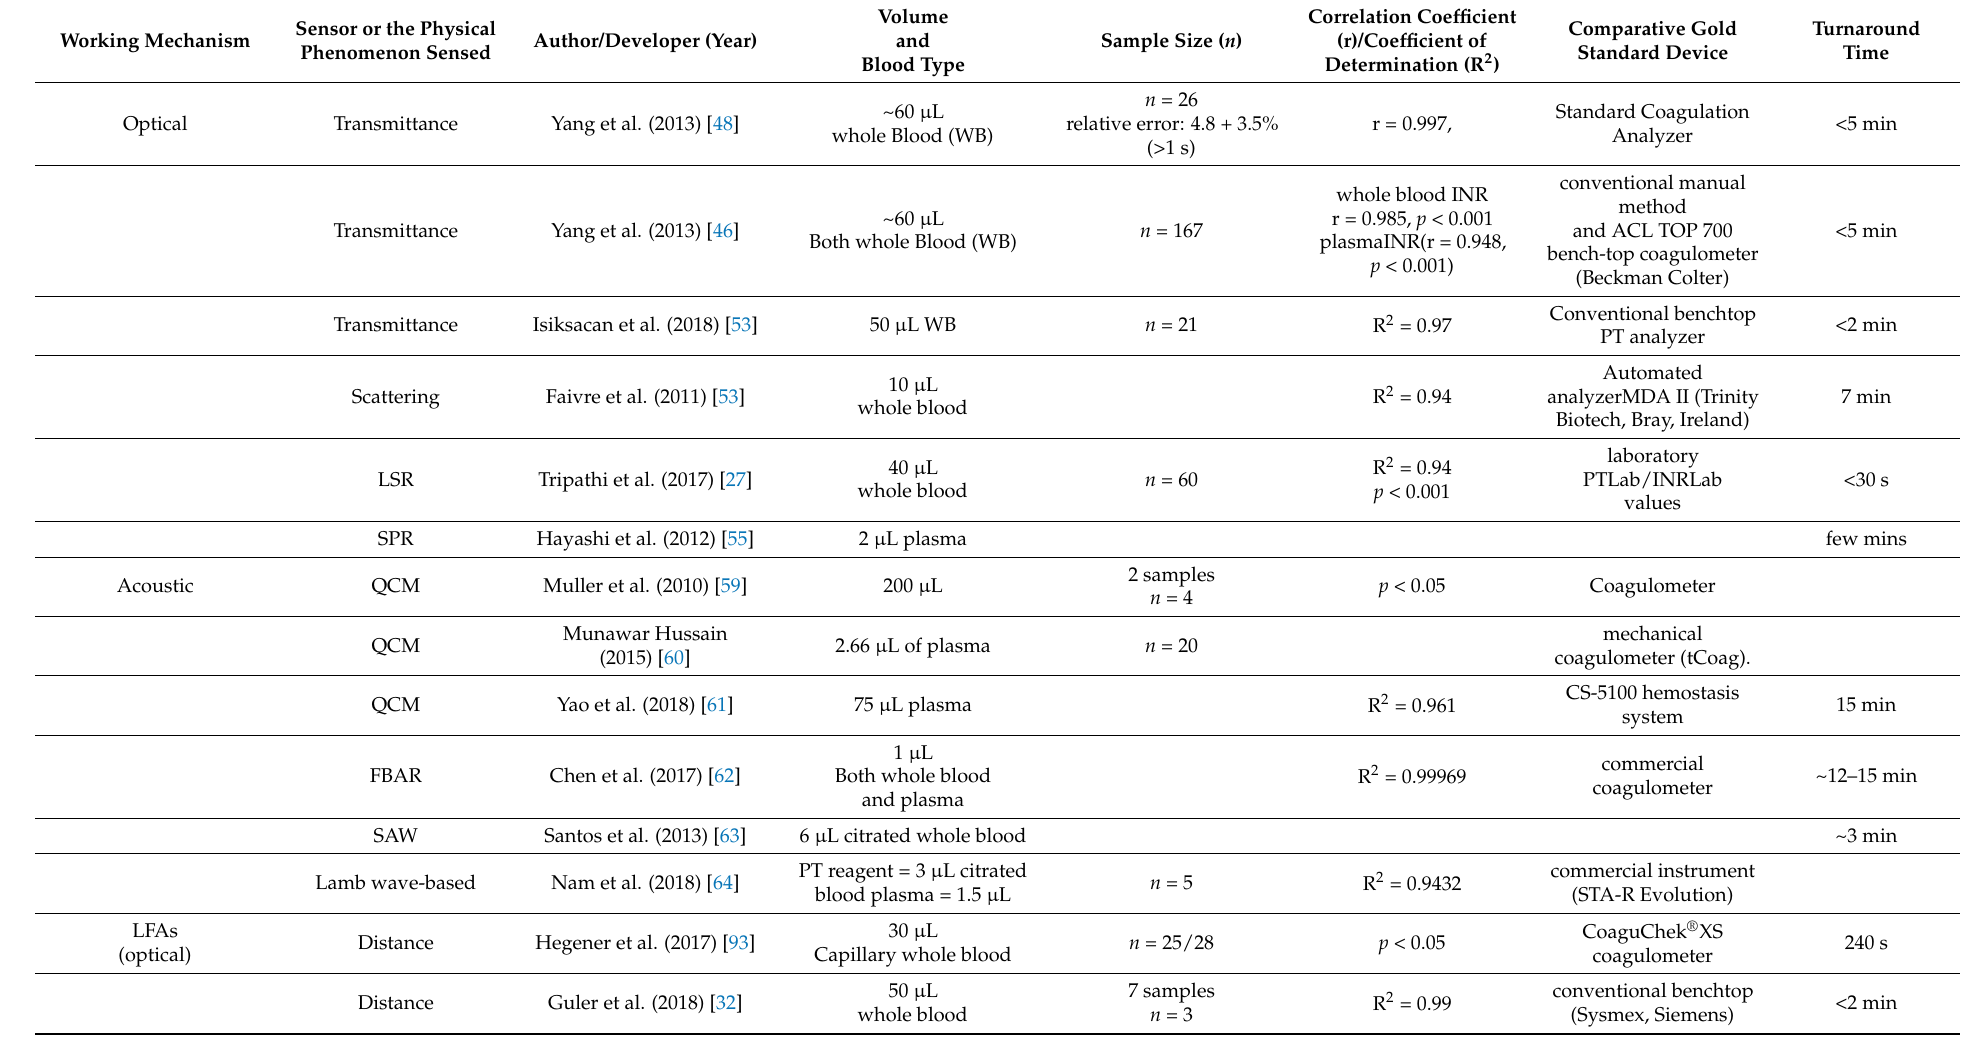
Table 2. Summary of the (PT/INR) measurement devices with their respective techniques and